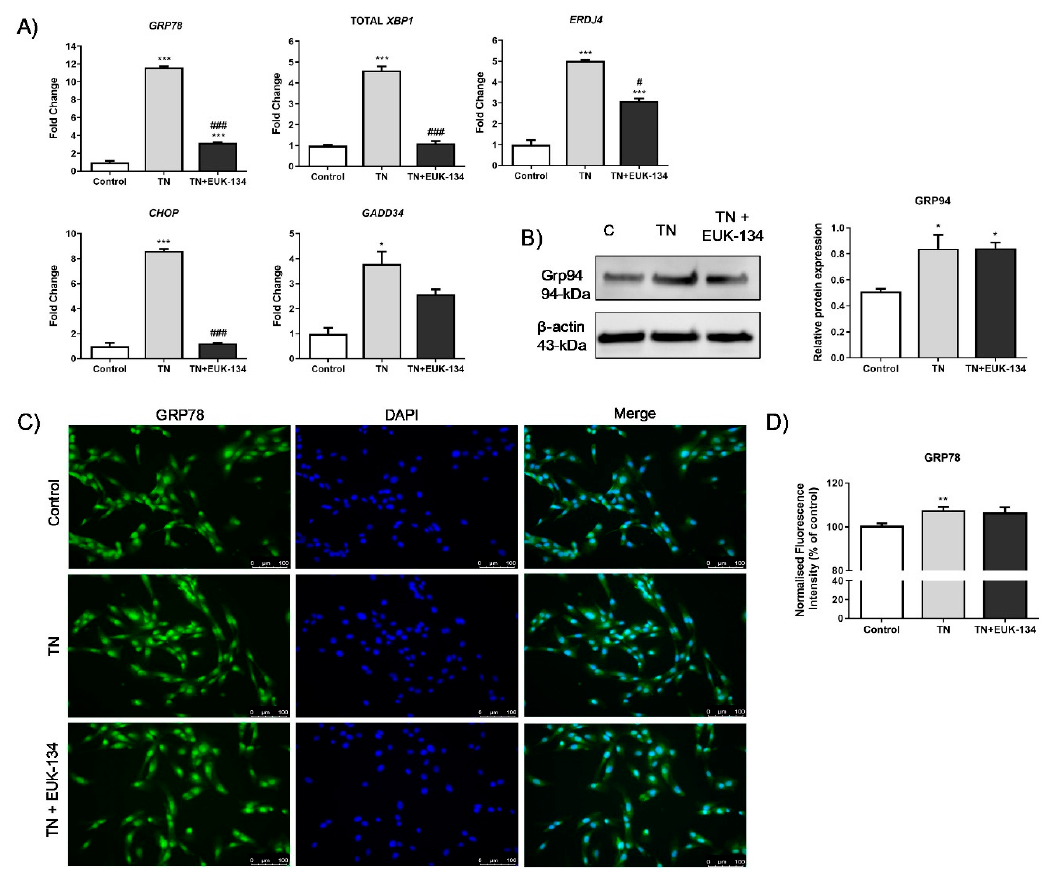
Figure 1. ER stress activation in tunicamycin-treated cells with or without EUK-134. ( A ) Relative fold changes in gene expression for ER stress markers. Data represent the mean fold change normalised to 18S housekeeper gene ± SEM of ∆ Ct values ( n = 3). ( B ) Cropped representative Western blot image and quantification of GRP94 protein levels relative to β -actin (loading control). Data represent the mean ± SEM ( n = 3). ( C ) Representative images of human skeletal muscle myoblast stained for GRP78 (green) and DAPI (blue). Images captured at 20 × magnification. Scale bar = 100 µ m. Brightness was adjusted equally in each image to enhance visualisation. ( D ) Quantification of total GRP78 fluorescence intensity normalised to nuclei number, relative to control (%). Data represent the mean ± SEM ( n = 26). * p ≤ 0.033, ** p < 0.002, and *** p < 0.001 against vehicle control or tunicamycin alone (#).